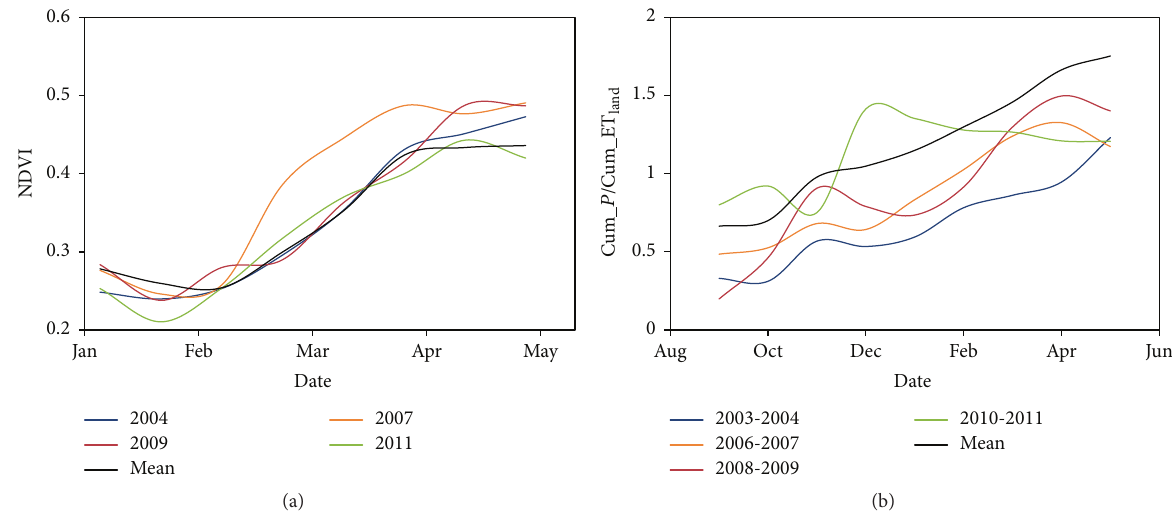
Figure 10: Variation in (a) the NDVI from January to May and (b) the ratio of the accumulated precipitation and ET from September to May during the drought years of 2004, 2007, 2009, and